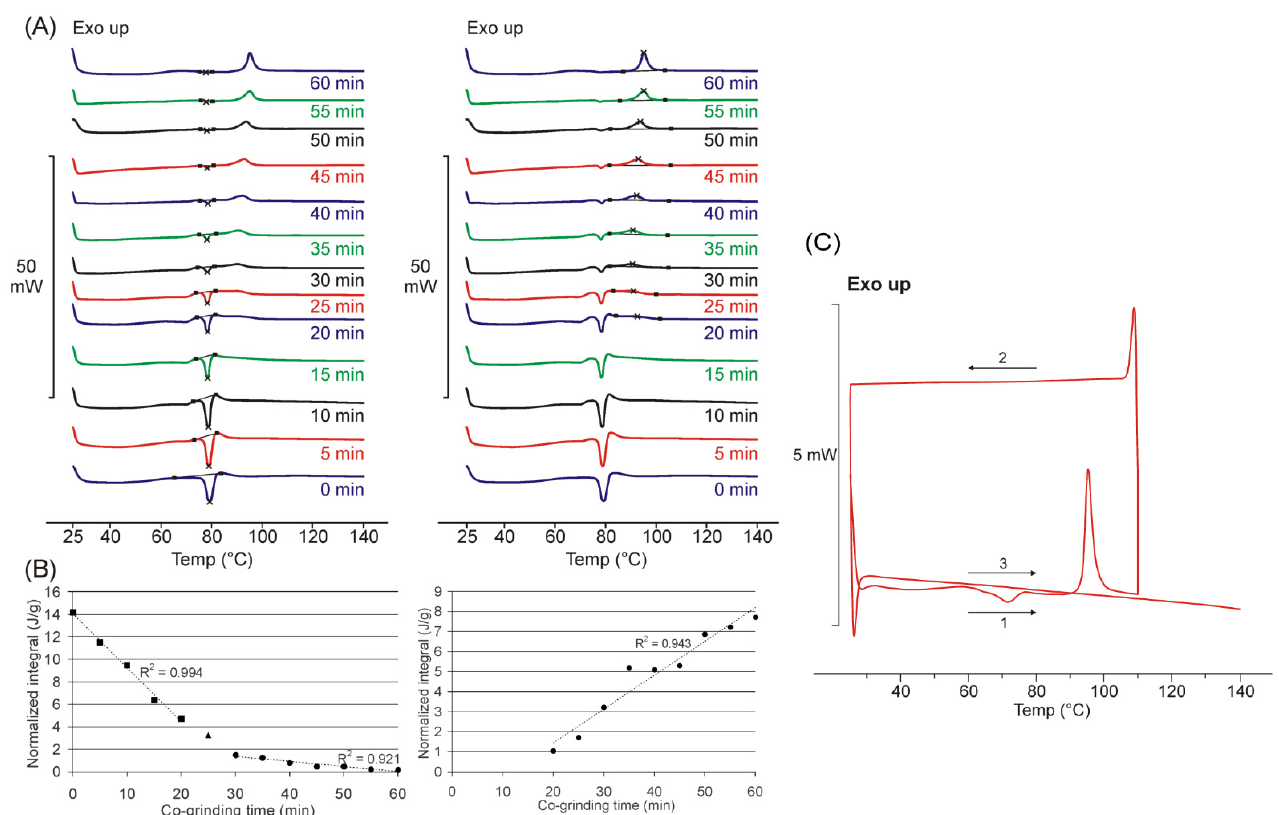
Figure 1. DSC curves of co-ground products show decreasing endothermic (ca. 80.5 °C) and increasing exothermic peak with the increasing grinding time, peak points were marked with × ( A ), and the corresponding normalized integral of the areas plotted as a function of grinding time ( B ).